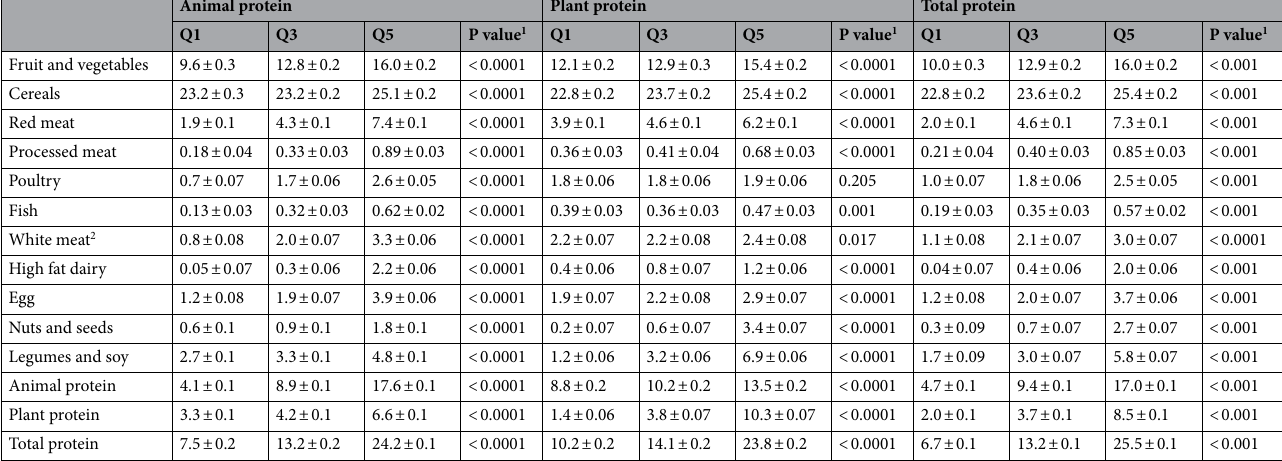
Table 2. Dietary intakes of participants according to quintiles of protein sources in the ICS. Values are age- and sex-adjusted Mean ± SE of frequency consumption/week. 1 Derived from ANCOVA. 2 White meat includes poultry and